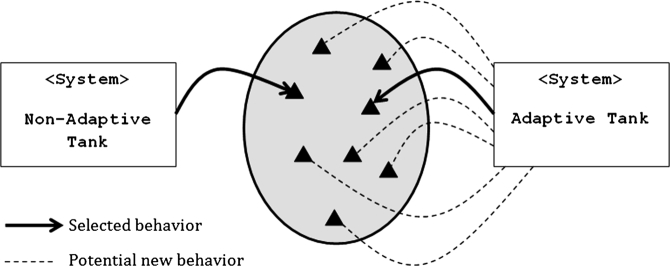
Behavior choice.